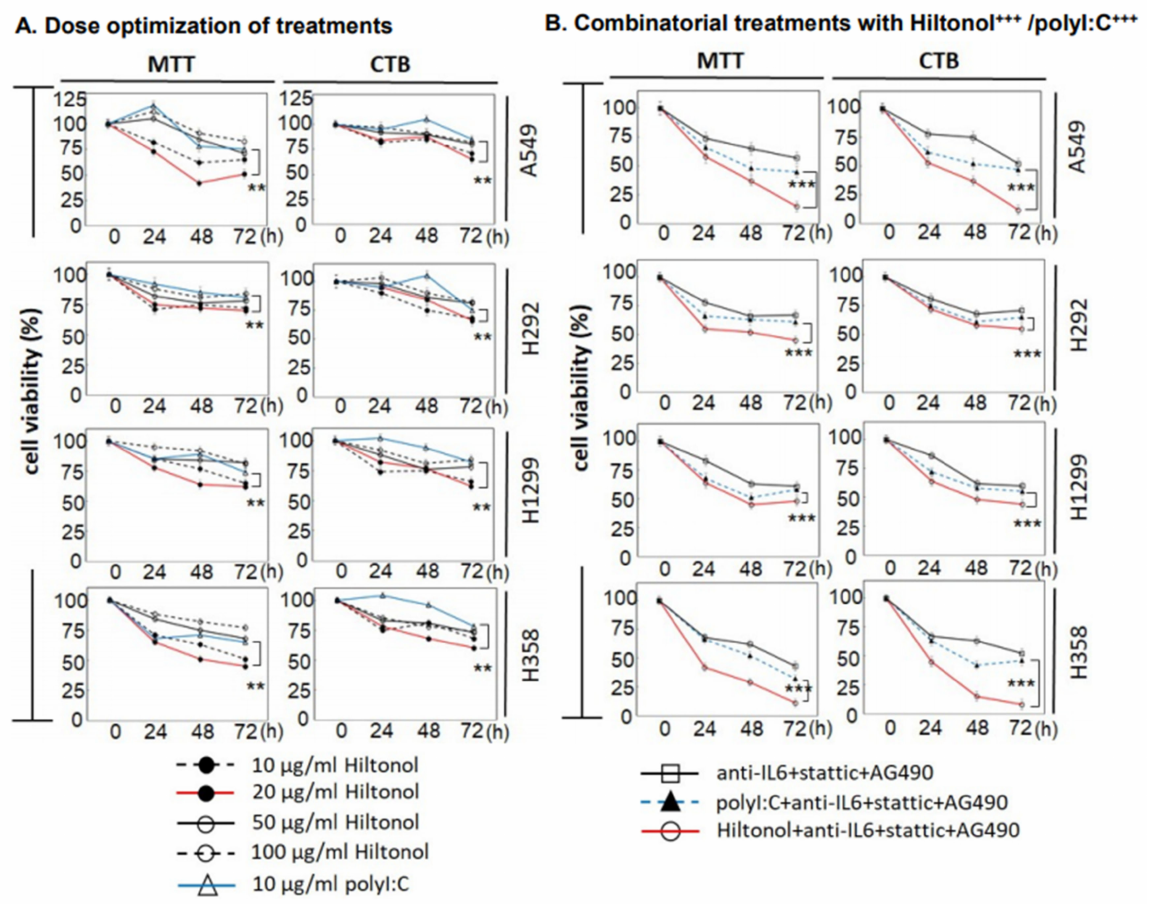
Figure 1. Treatment of human lung cancer cell lines (A549, H292, H1299, and H358) with Hiltonol+anti-IL6+stattic+AG490 (Hiltonol +++ ) significantly suppressed cancer cell survival. ( A ) Dose optimization of Hiltonol and polyI:C (polyinosinic- polycytidilic acid) was performed and cell survival was assayed using MTT {3-(4,5-dimethylathiazol-2-yl)-2,5-diphenyl tetrazolium bromide} and CTB (CellTiter Blue). Both assays consistently showed that Hiltonol significantly suppressed the cell viability. The optimal killing dose of Hiltonol is 20 µ g/mL (red line), compared to polyI:C (blue line) (**, p < 0.01). Differences between averages were analyzed by two-way ANOVA (two-way analysis of variance) with interaction. Doses and cell lines were considered as two factors in the two-way ANOVA. In MTT assays, LSD (Least Significant Difference) value in A549, H292, H1299, and H358 are 3.902, 3.334, 2.172, and 2.046, respectively. In CTB assays, LSD value in A549, H292, H1299, and H358 are 3.063, 2.939, 2.28, and 1.739, respectively. ( B ) Combinatorial treatments with Hiltonol +++ (red line) or with polyI:C +++ (blue line) further reduced cancer cell survival, with up to 1.7-fold greater killing by Hiltonol +++ compared to polyI:C +++ (***, p < 0.001). Data are representative of means ± SD ( n = 3). For each time point, cell counts were normalized to corresponding DMSO (or PBS (phosphate buffered saline))-treated controls. In MTT assays, the LSD value in A549, H292, H1299, and H358 are 3.745, 2.341, 3.004, and 2.489, respectively. In CTB assays, the LSD value in A549, H292, H1299, and H358 are 3.222, 2.969, 3.423, and 3.396,